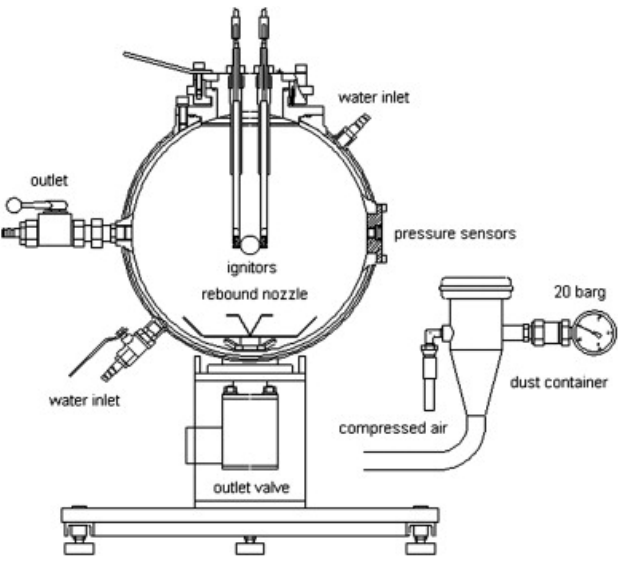
Figure 2. 20 L apparatus (Kühner AG) (Reprinted Ref. [26]). Lycopodium clavatum was used as a standard sample, Figure 3. Explosion parameters of Lycopodium clavatum were measured in the KV 150M2 chamber. Explosion parameters of the sample of magnesium powder ( − 325 mesh, up to 45 µm) and benzoic acid were tested in the 20 L sphere explosion chamber, Figure 1. The parameters to be compared were measured at the concentrations of 250 and 500 g·m − 3 , and also at the concentrations of 750 and 1000 g·m − 3 in the case of benzoic acid.